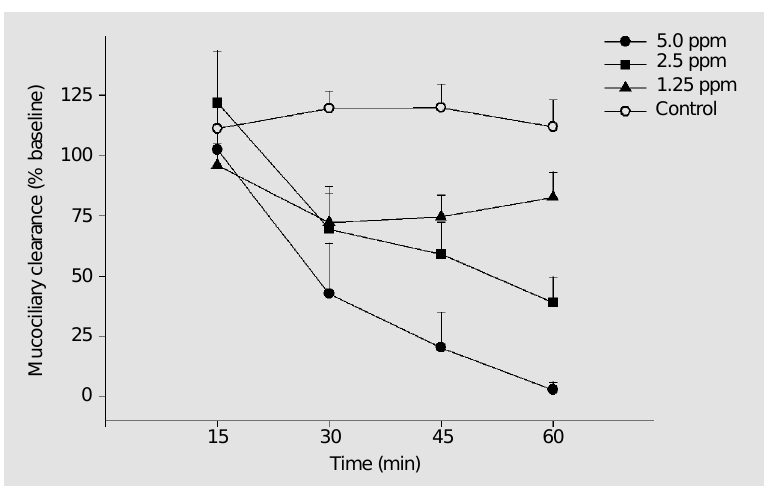
Figure 1 - Mean (± SEM) values of relative change in mucociliary clearance (MC) measured after immersion in Ringer or different concentrations of formaldehyde. The relative changes were obtained by dividing all observations of each assay by the corresponding baseline value. MC decreased significantly in the presence of 2.5 and 5.0 ppm of formaldehyde at 60 min (P<0.05).